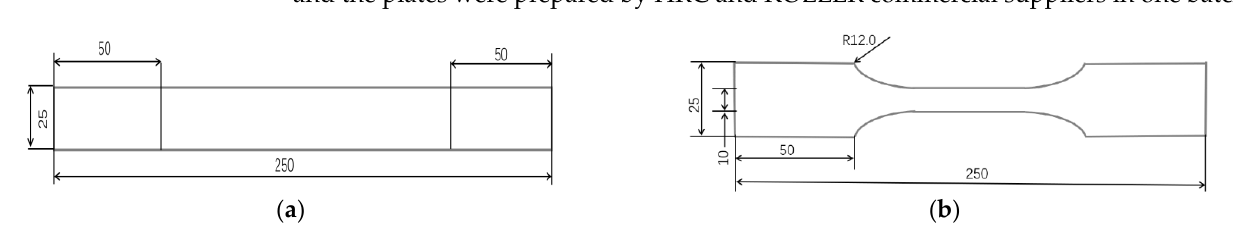
Figure 1b. The tensile specimens were wire-cut from a 300 mm × 400 mm × 2 mm plate,